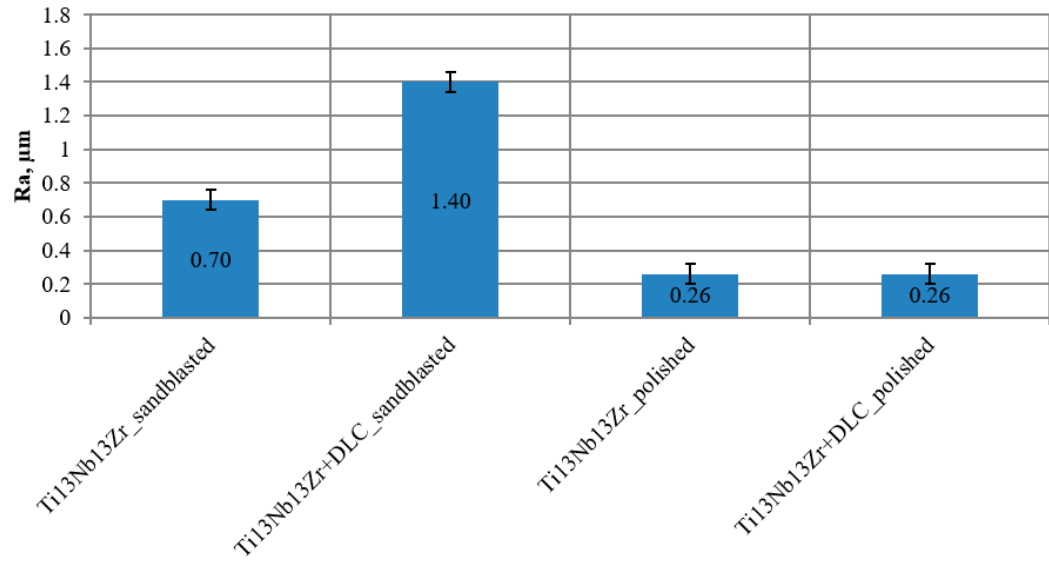
Figure 4. Mean surface roughness values.